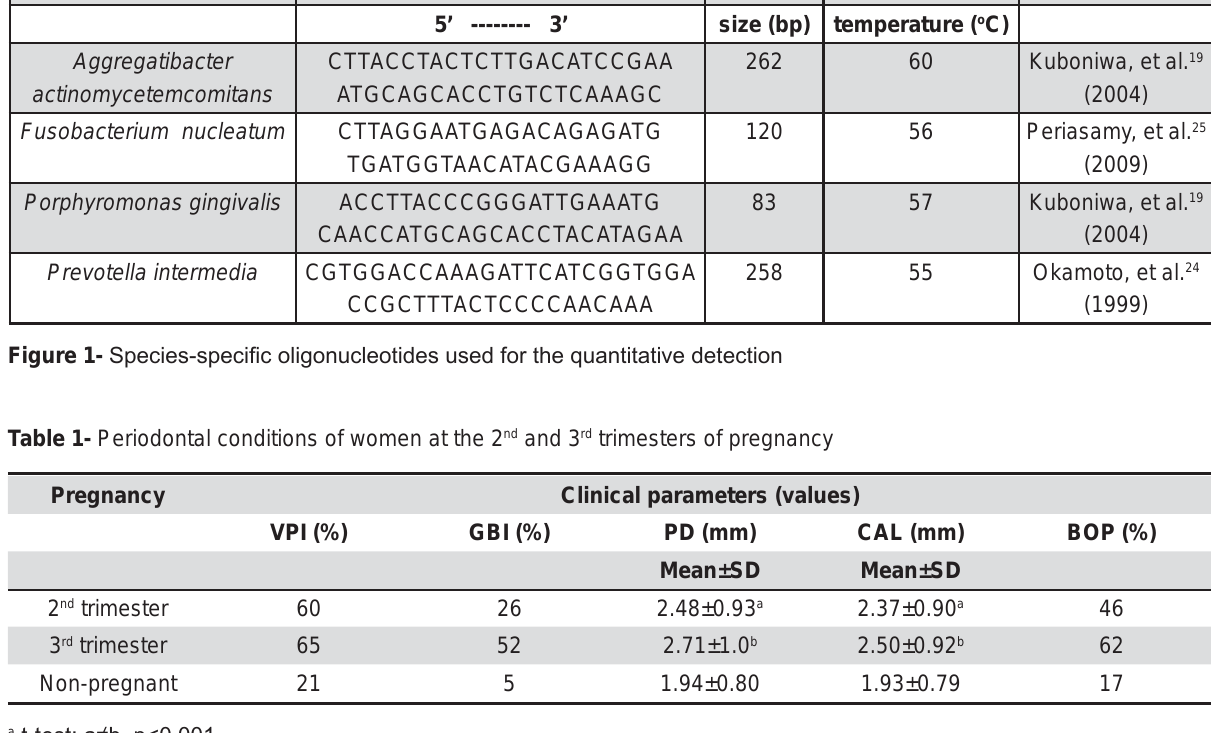
a (cid:3)(cid:87)(cid:16)(cid:87)(cid:72)(cid:86)(cid:87)(cid:29)(cid:3)(cid:68)(cid:143)(cid:69)(cid:15)(cid:3)(cid:83)(cid:31)(cid:19)(cid:17)(cid:19)(cid:19)(cid:20) VPI: visible plaque index; GBI: gingival bleeding index; PD: probing depth; CAL: clinical attachment level; BOP: bleeding on